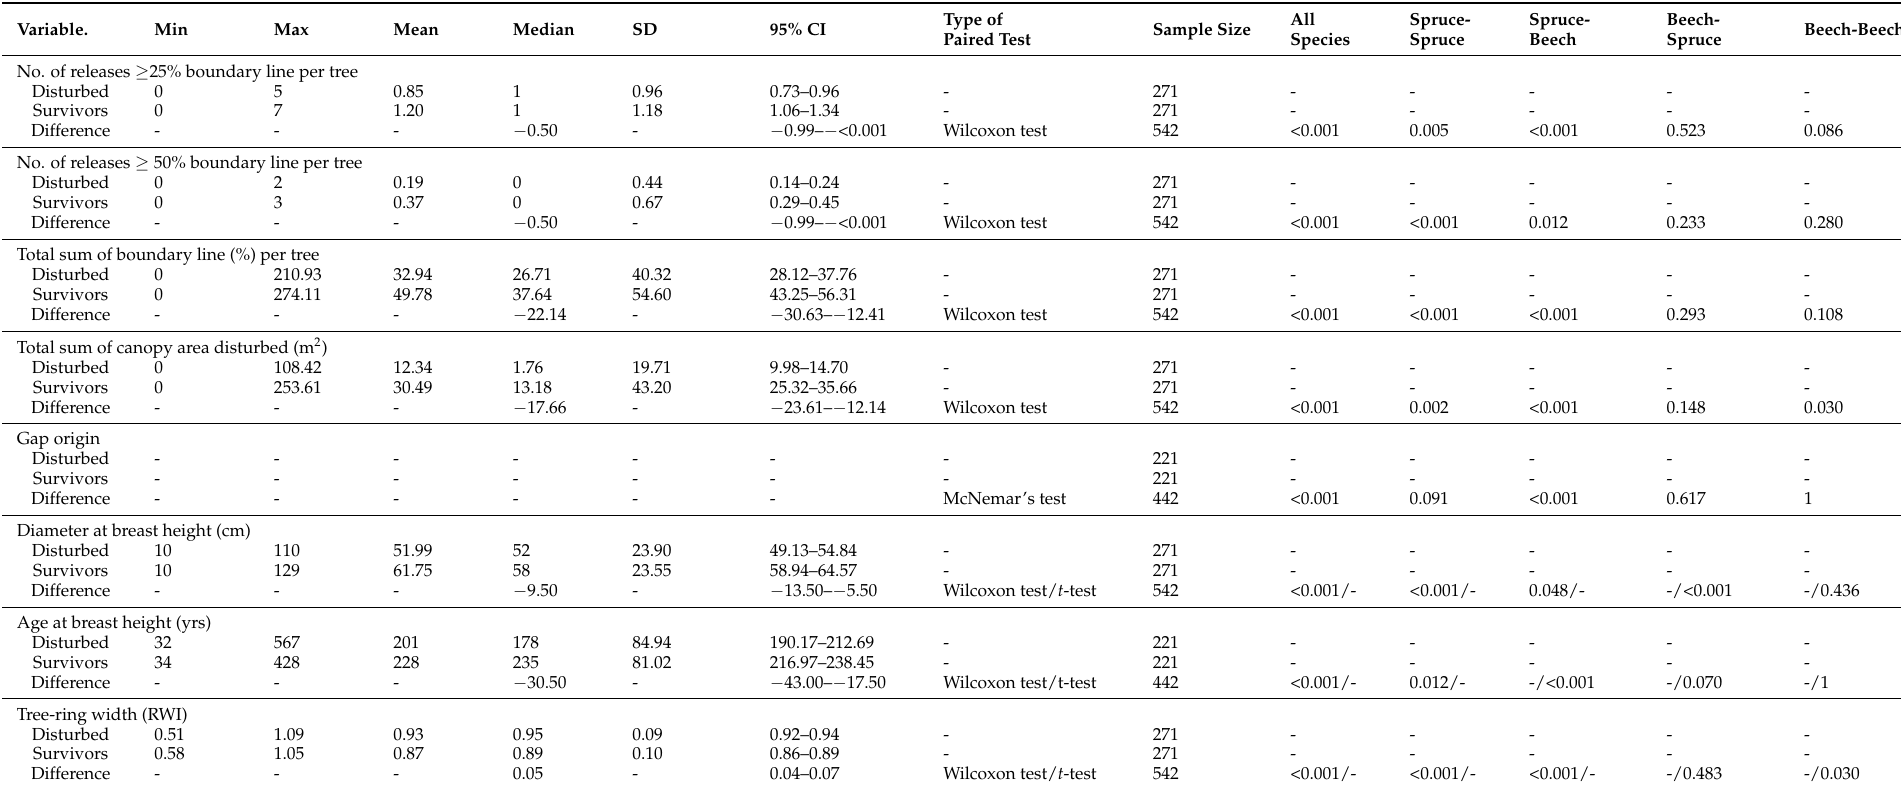
Table 2. Results of paired tests for Historical, Size and Material hypotheses, including the descriptive statistics for all examined variables and type of paired test used. Rows contain descriptive statistics for disturbed and survivor datasets and their differences, as demonstrated by median, 95% confidence interval width and p -value of paired tests (right side of the table). Tests were performed for all tree species together as well as separately for particular species pairs.